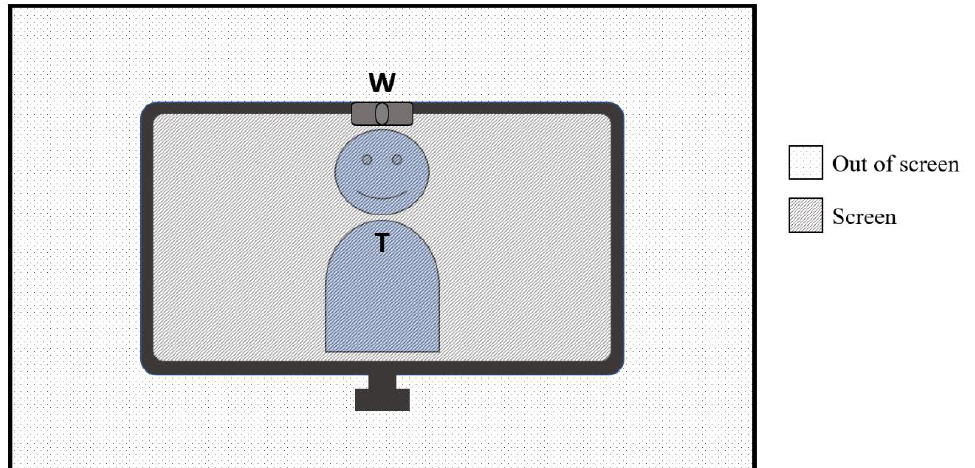
Figure 1. The depiction of off-screen versus on-screen portions of the visual scene from the client per- spective. Legend: T: Therapist. W: Webcam.